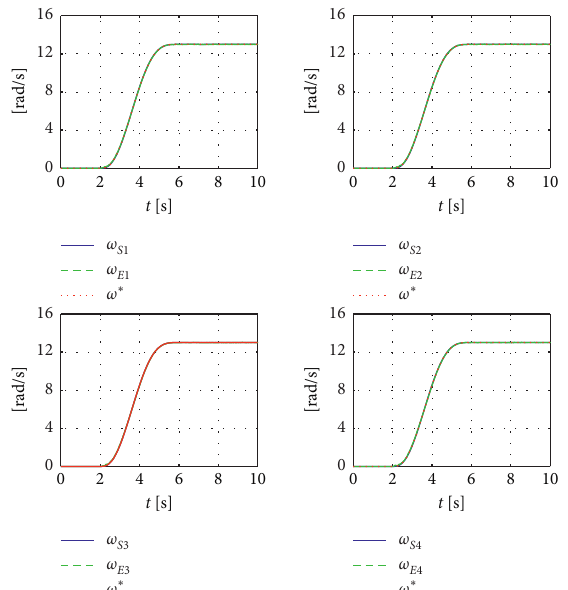
Figure 17: Assessment of the trajectory tracking task for the angular velocity ω associated with the DC/DC Buck converter-DC motor system, via a direct visual comparison between the simulation and experimental results.